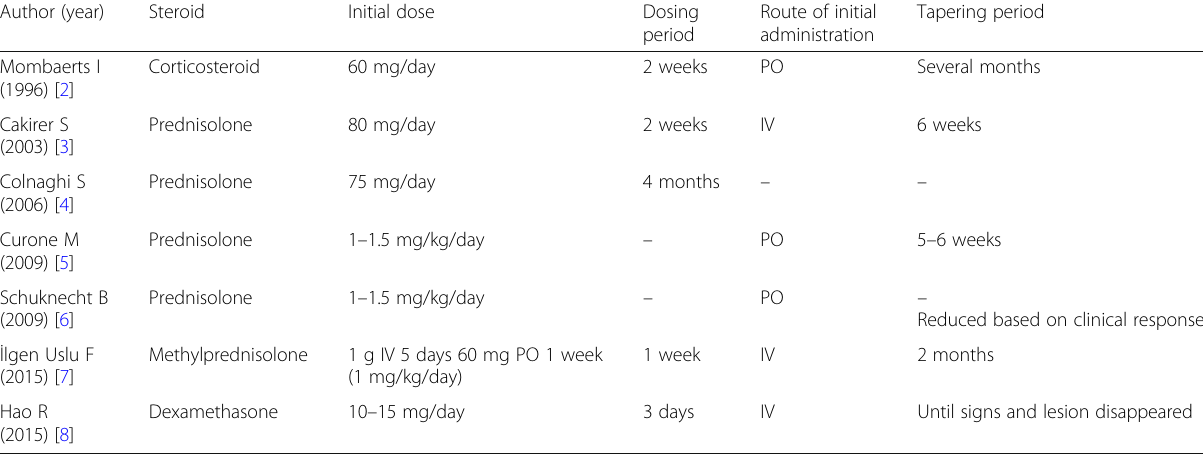
Table 1 Case reports involving patients who were given corticosteroid